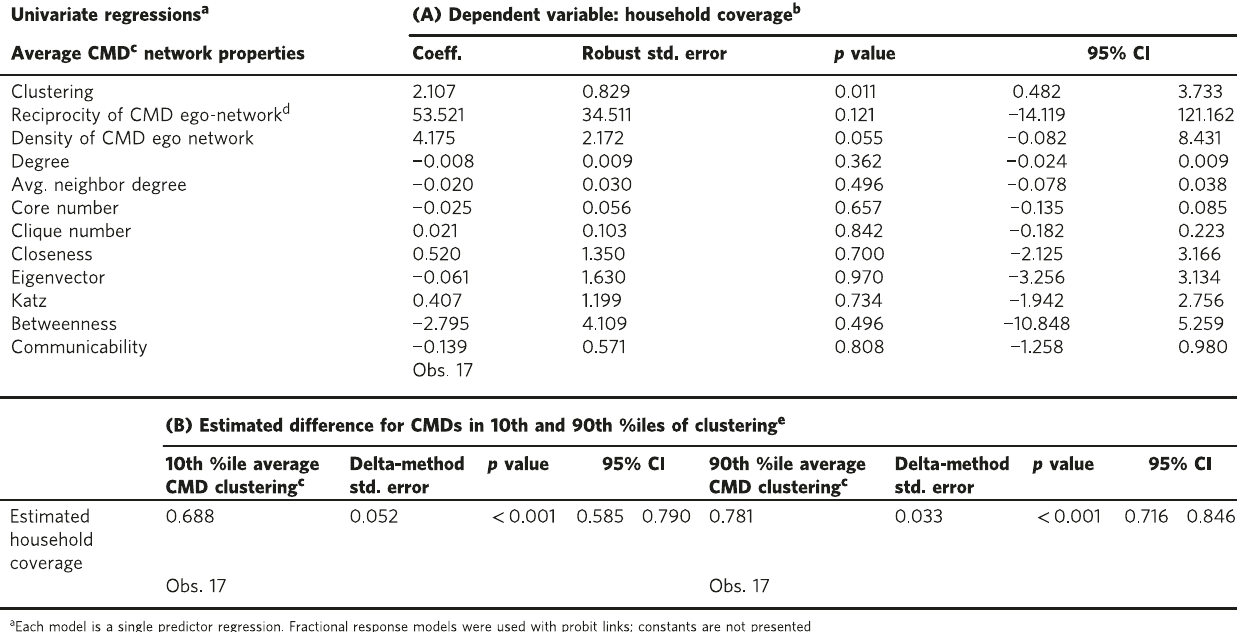
Table 1 In fl uence of CMD network properties on village treatment